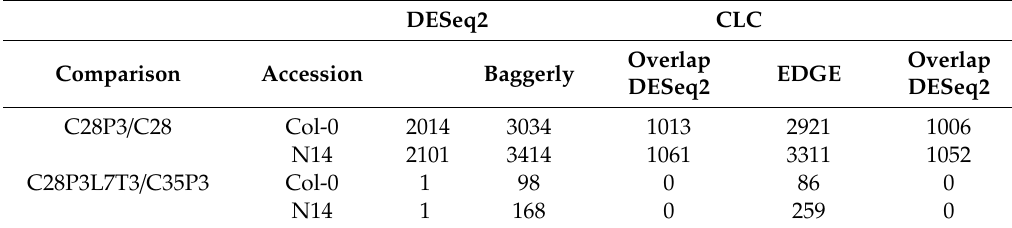
Table 2. DGE analysis using the CLC